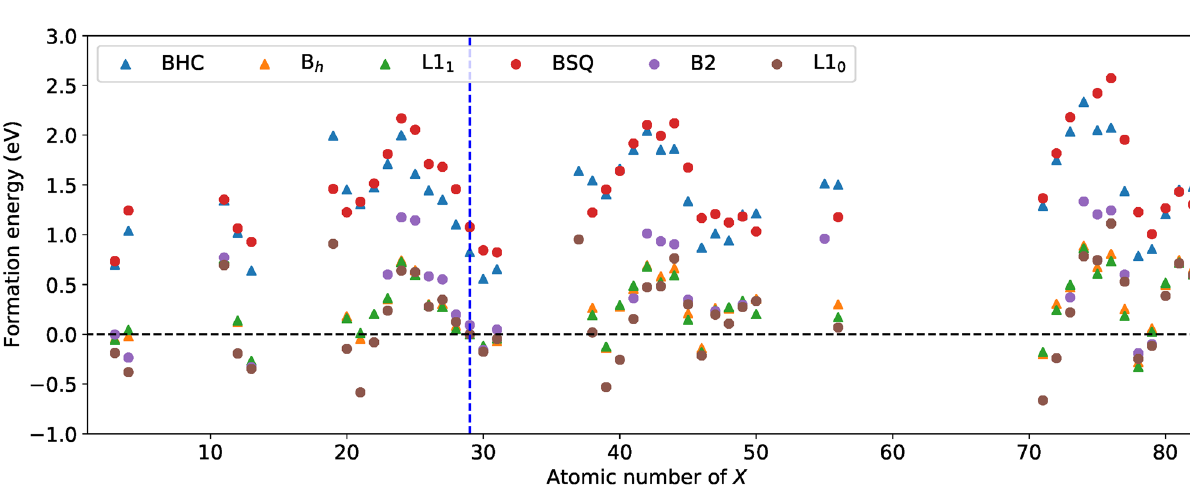
Figure 4. The formation energy (per a unit cell including two atoms) of Cu X in the BHC, B h , L1 1 , BSQ, B2, and L1 0 . The vertical dashed line (blue) indicates the case of X = Cu